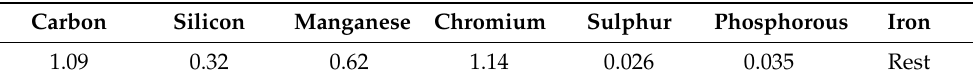
Table 3. EN31 steel composition.